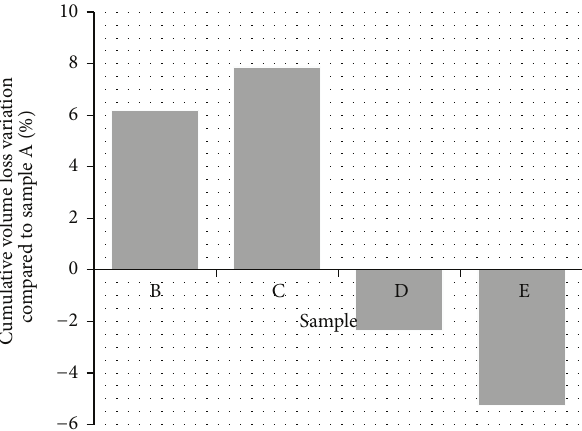
Figure 3: Cumulative mass loss.